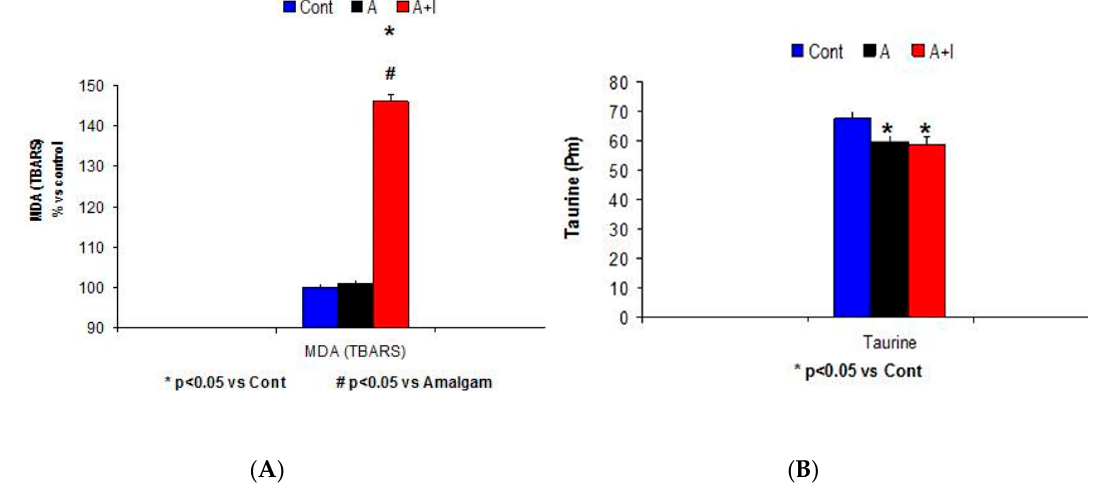
Figure-3. Higher systemic Malondialdehyde (MDA) levels ( A ) and lower systemic taurine (pM) levels ( B ) Figure 3. Higher systemic malondialdehyde (MDA) levels ( A ) and lower systemic taurine (pM) levels